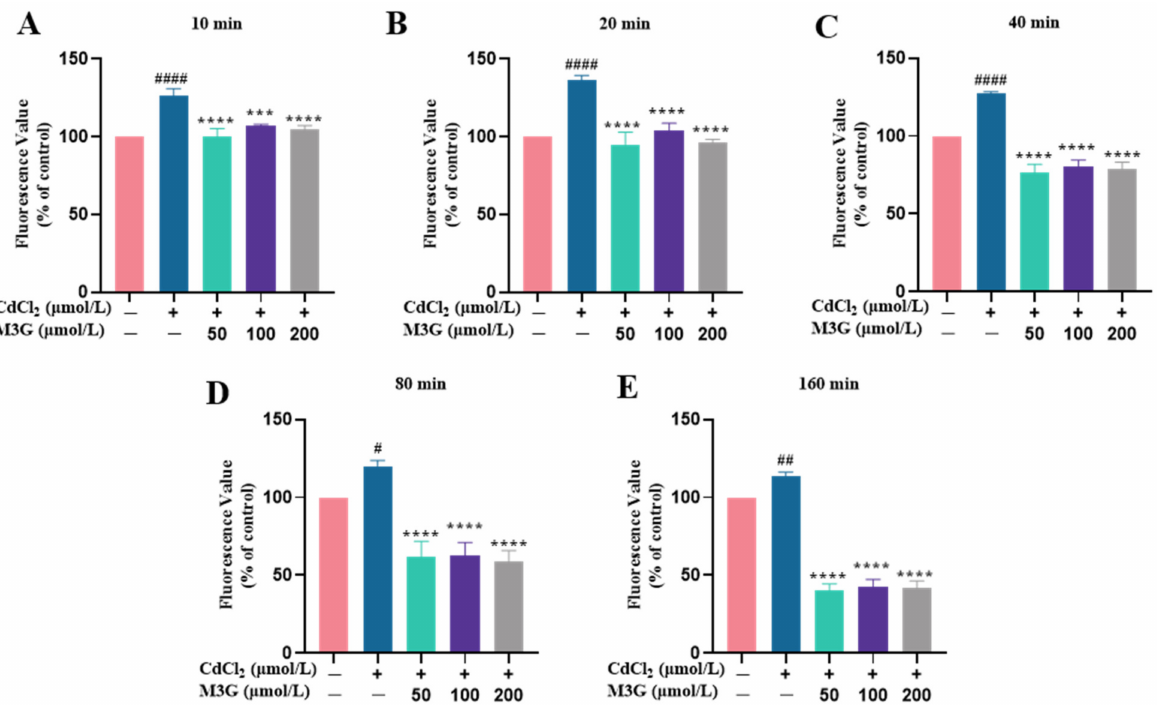
Figure 3. M3G reduces ROS levels in CdCl 2 -exposed KGN cells. ROS levels of KGN cells were treated for ( A ) 10, ( B ) 20, ( C ) 40, ( D ) 80, and ( E ) 160 min with 10 µ mol/L CdCl 2 alone and in combination with 50-200 µ mol/L M3G. Mean ± SD, n = 3. # p < 0.05, ## p < 0.01, #### p < 0.0001, vs. control; *** p < 0.001, **** p < 0.0001, vs. CdCl 2 -treated